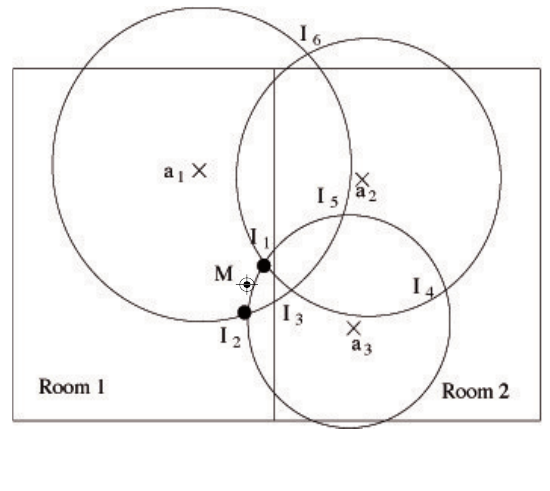
Figure 3. The modified version of the received signal strength (RSS)-based trilateration algorithm; only the intersection points inside the room selected by the Prediction subsystem are